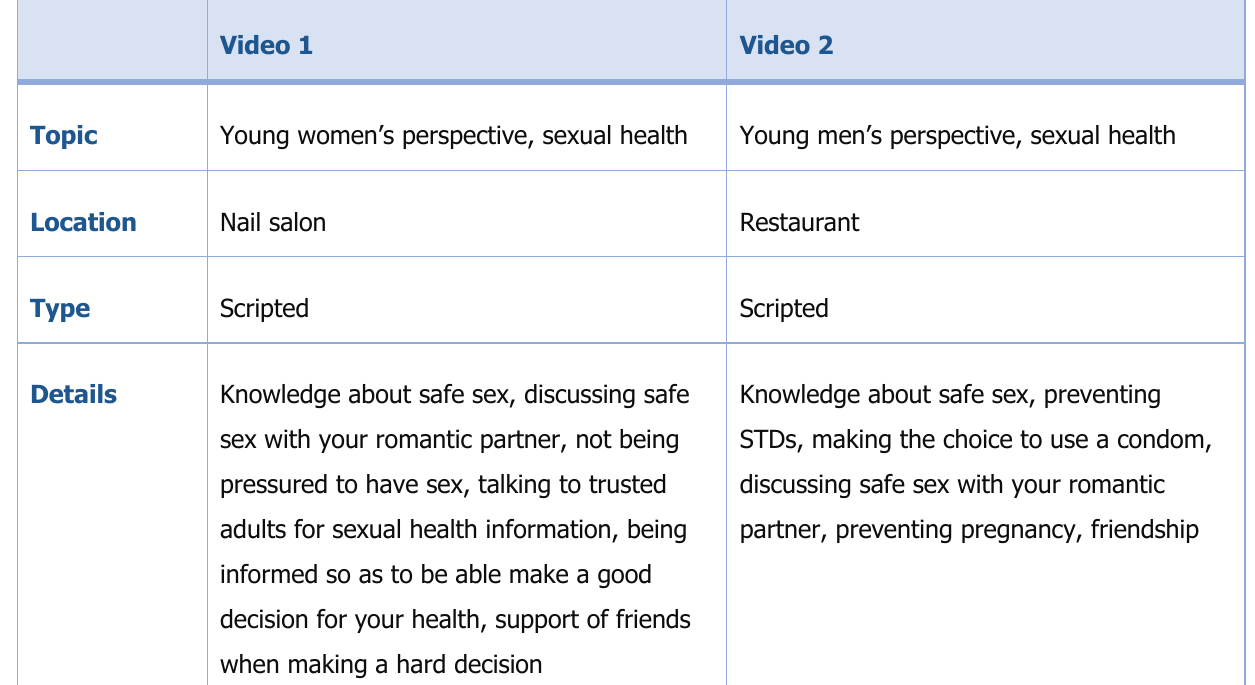
Table 2. Details for Adelante Ambassadors Videos with the Themes: Adelante Is and Making Good